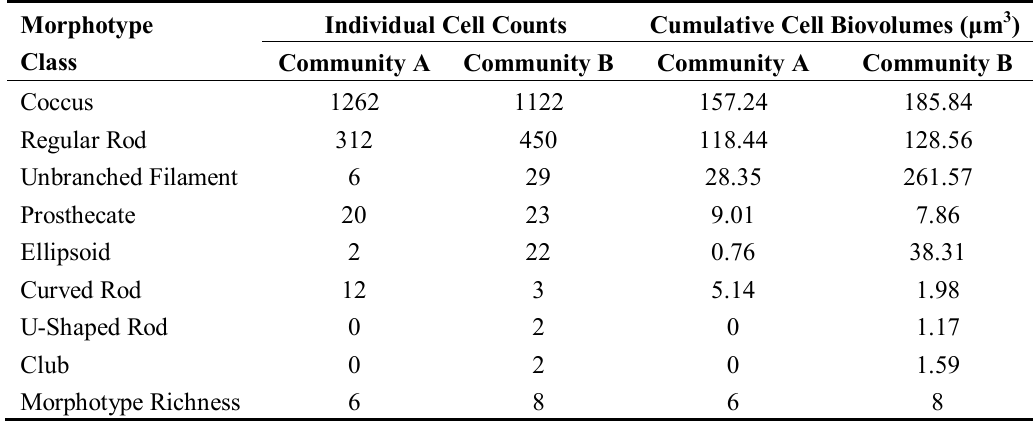
Table 2 . The distribution of abundance for each morphotype class in images of biofilm communities A and